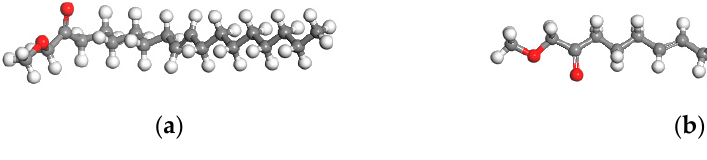
color-coding scheme is as follows: blue = aromatics, gray = asphaltenes, green = resins, pink = saturates, red = 1 − 5% C 18 H 32 O 2 , and yellow = 1 − 3% C 18 H 34 O 2